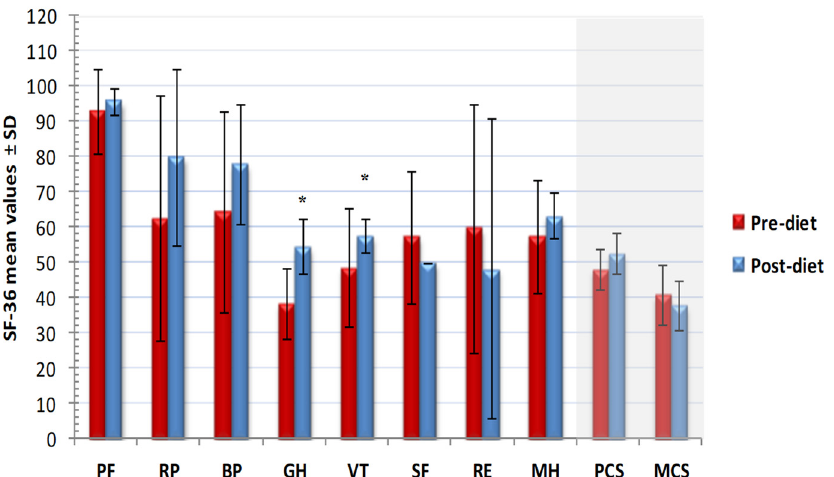
Figure 5. Changes of short form 36 items health survey (SF-36) psychometric indices after low nickel diet. PF, physical function; RP, role-physical; BP, bodily pain; GH, general health; VT, vitality; SF, social function; RE, role-emotional; MH, mental health; PCS, physical component summary; MCS, mental component summary; *: p < 0.05 (two-tailed paired Student’s t-test).